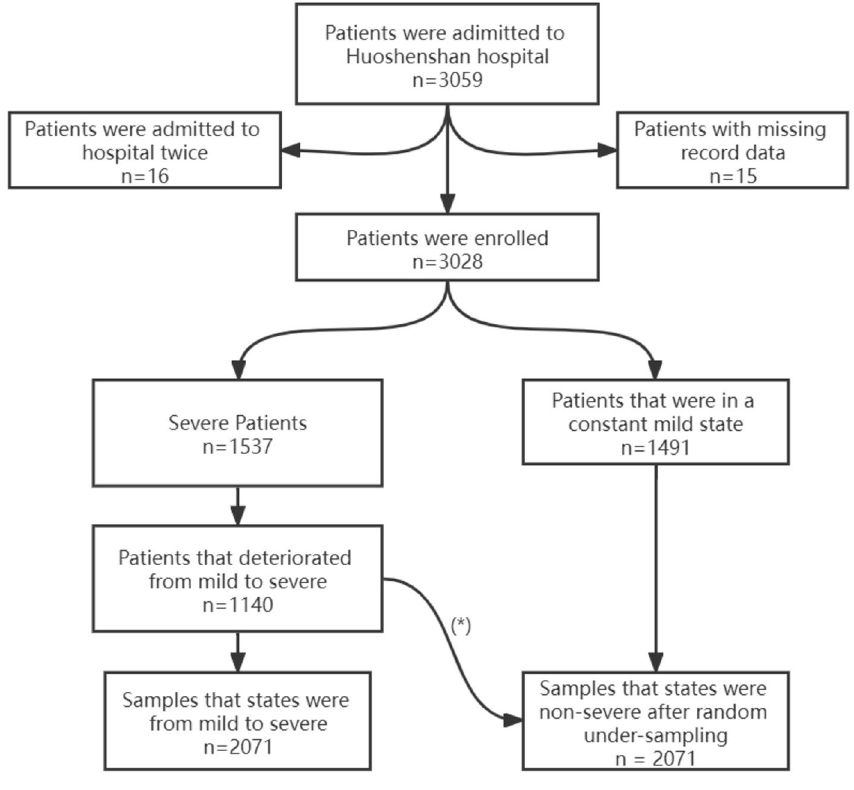
Figure 1. The sample set extraction